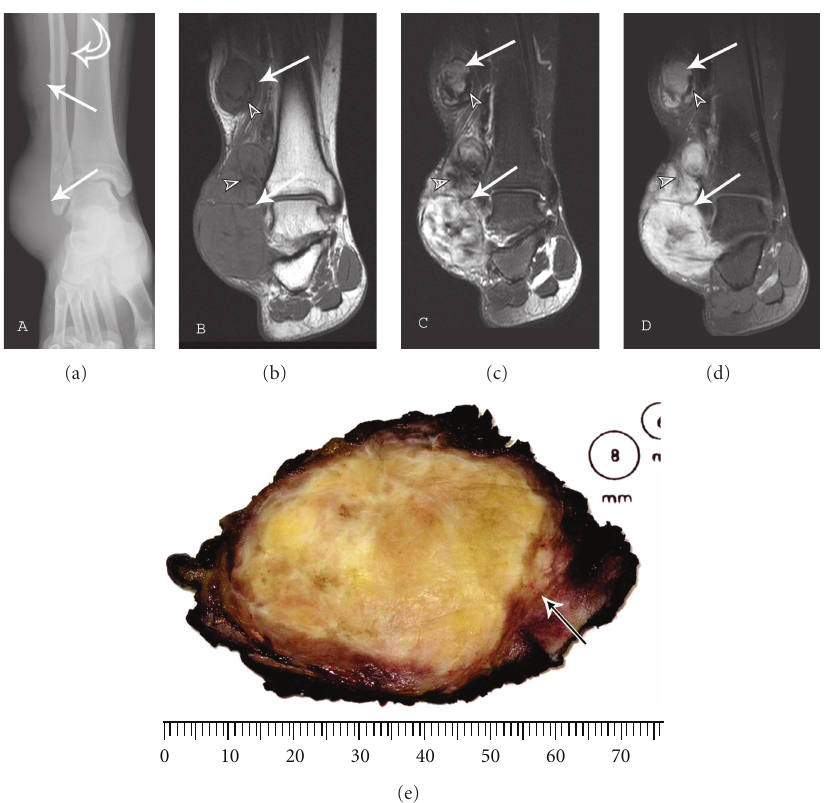
Figure 4: Multicentric extraabdominal fibromatosis of the right ankle: a 22-year-old male with ankle pain with prolonged standing. (a) AP radiograph of the right ankle demonstrates soft tissues masses (arrows) and mature periosteal reaction (curved arrow) of the fibula adjacent to the proximal lesion. (b) Coronal T1-weighted (TR420/TE10) sequence reveals predominantly intermediate signal lesions (arrows) of the subcutaneous tissues of the lateral ankle. (c) Coronal T2-weighted (TR4730.91/TE70) fat saturation image shows heterogeneous lesions (arrows) with moderate to marked enhancement on the (d) coronal T1-weighted (TR420/TE10) postcontrast fat suppression image. Low-signal-intensity bands (small arrowheads) of mature collagenized tissue within this desmoid tumor are best appreciated on the T2FS sequence. Photograph (e) of resected gross specimen demonstrates infiltrative borders (arrow) and a coarsely trabeculated